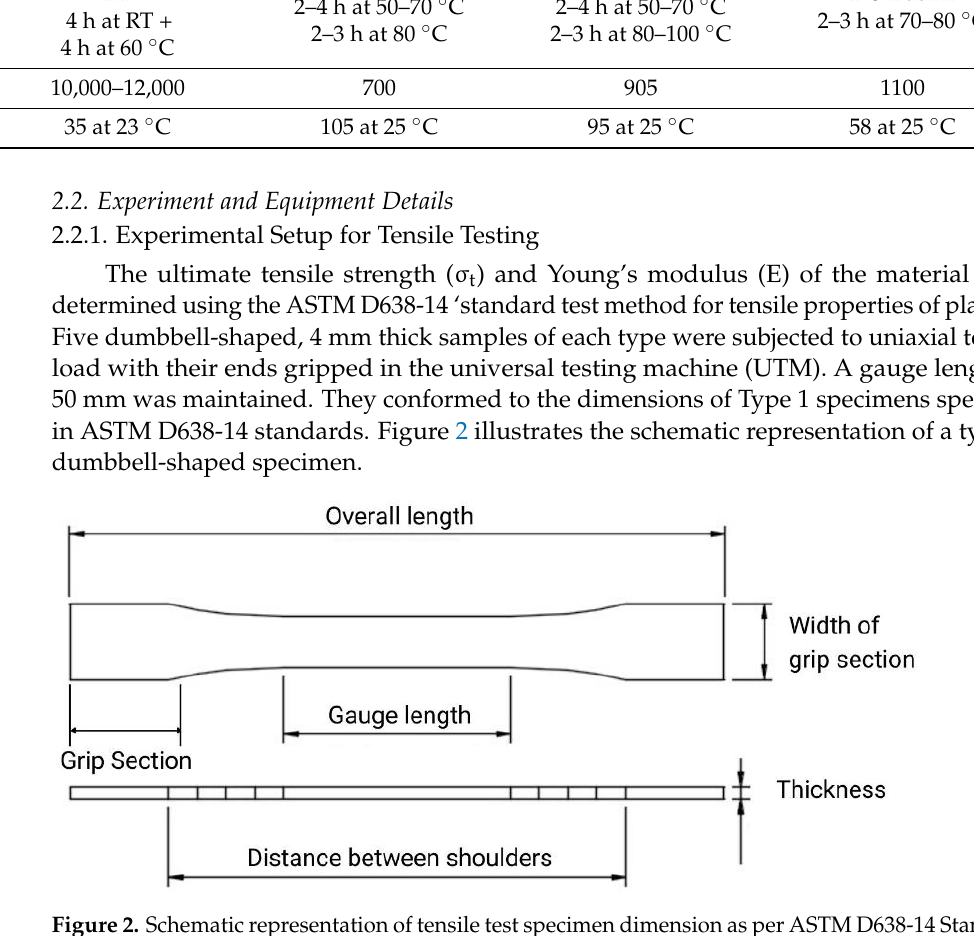
Figure 2. Schematic representation of tensile test specimen dimension as per ASTM D638-14 Stand- ard.